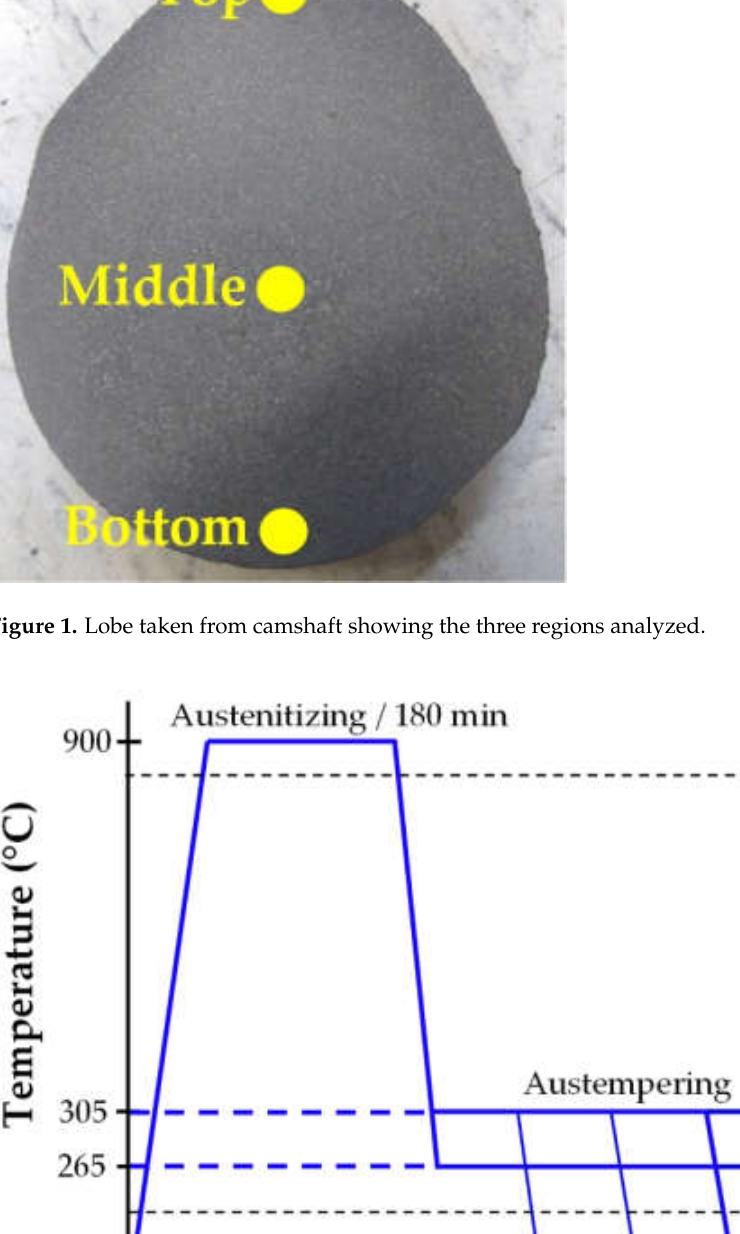
Figure 1. Lobe taken from camshaft showing the three regions analyzed.